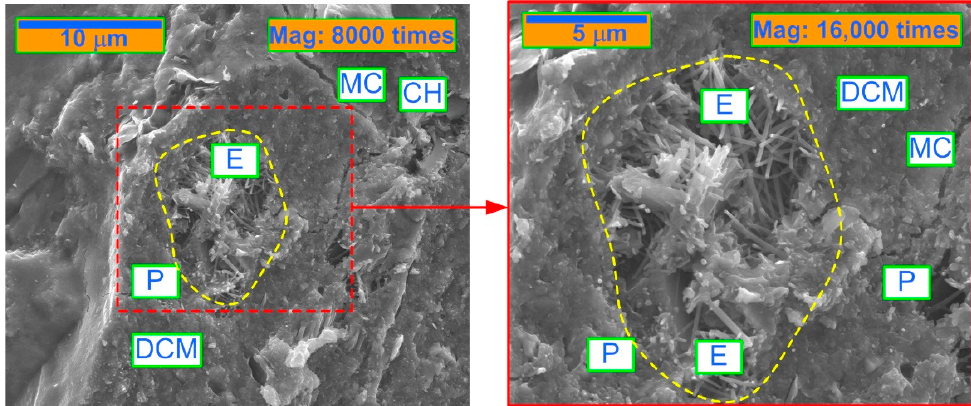
Figure 7. SEM microimages of analyzed T1 concrete; descriptions in the text.